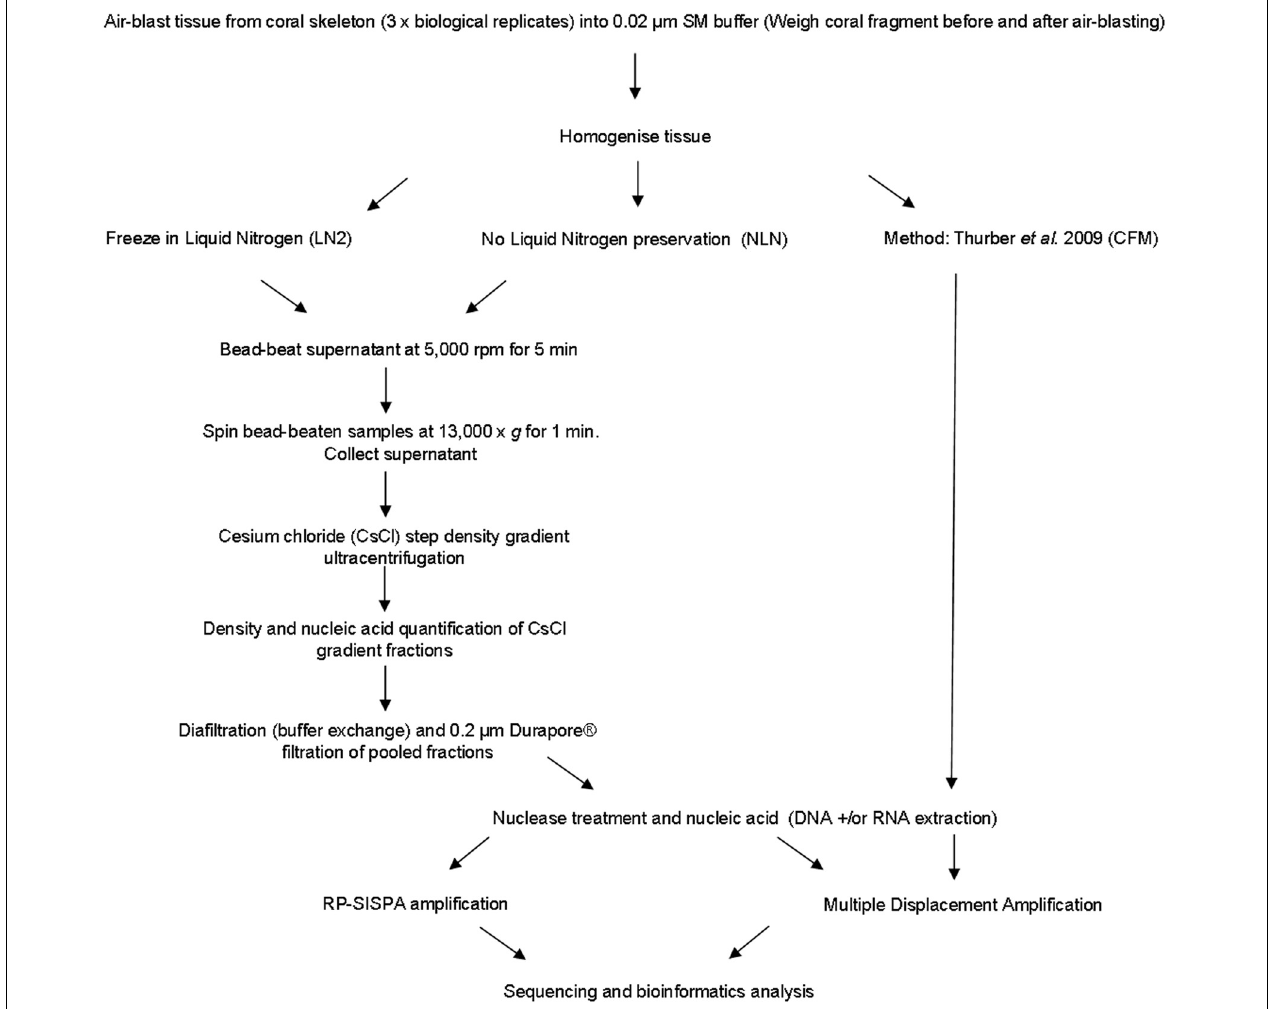
FIGURE 1 | Flowchart outlining the methods for generating viral metagenomes from coral tissue trialed in this study.